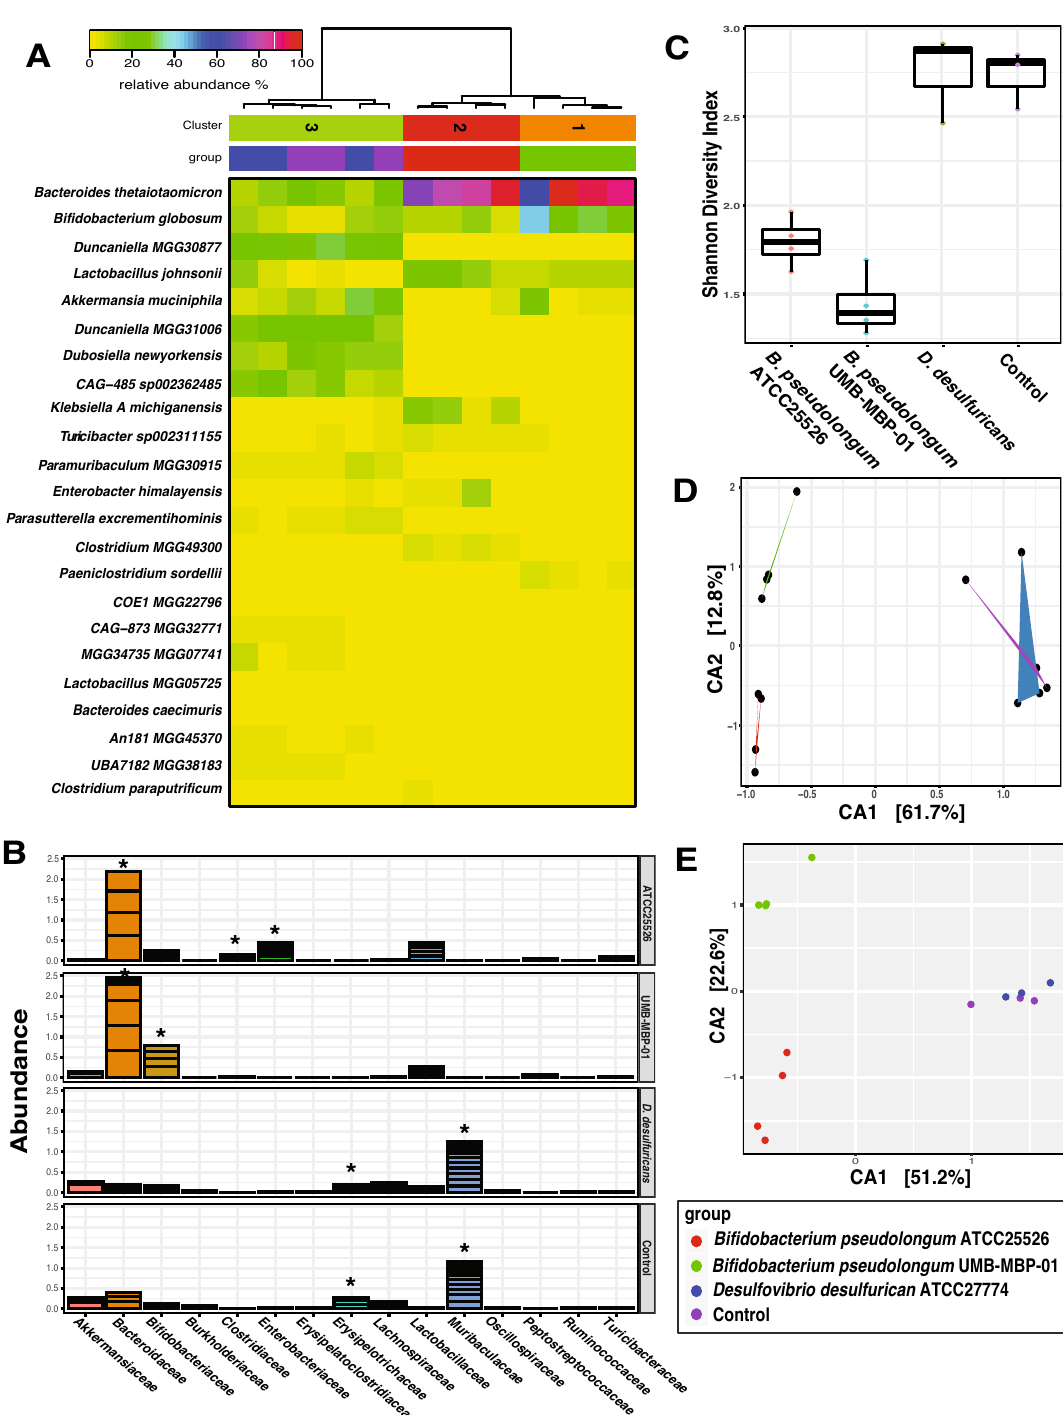
Figure 5. Alterations in gut microbiome after bacterial gavage. ( A ) Heatmap of the top most abundant intestinal bacterial taxa relative abundance in mice intraluminal samples. Ward linkage clustering based on Jensen-Shannon distance was calculated using the vegan package in R 101 . Taxonomic profiles of the microbial community were characterized using the comprehensive mouse gut metagenome (CMGM) catalog 40 . R codes and input dataset used to generate the heatmap was deposited in github (https:// github. com/ igsbma/ genome_ paper). ( B ) Cumulative relative abundance of major bacterial families. The relative abundances of each family are stacked in order from greatest to least, and are separated by a horizontal line. ( C ) Shannon diversity index (within-community diversity) of the four experimental groups. Canonical Correspondence Analysis (CCA) of ( D ) microbial functional pathways and ( E ) taxonomy. Pathways were characterized using HUMAnN2 (v0.11.2) 98 and Uniref90 database 97 based on Bray–Curtis distance. CA1 and CA2 selected as the major components based on the